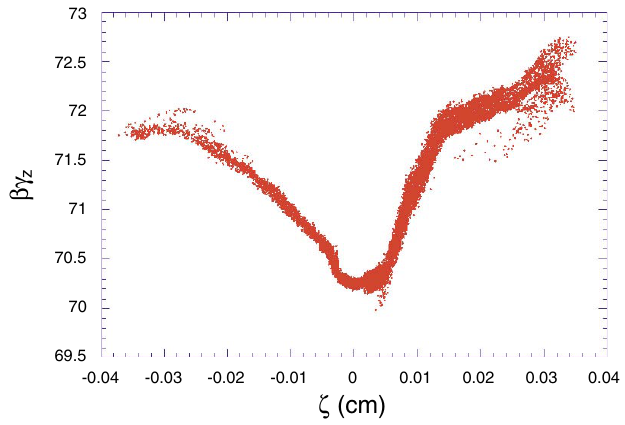
FIG. 6. (Color) Evolution of the rms transverse beam size and emittance for 1 nC beam in the ORION photoinjector, velocity- bunching case, from PARMELA